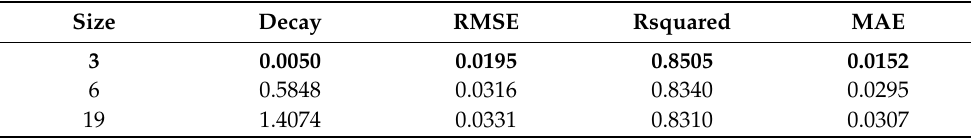
Table 2. Neural network with feature extraction.